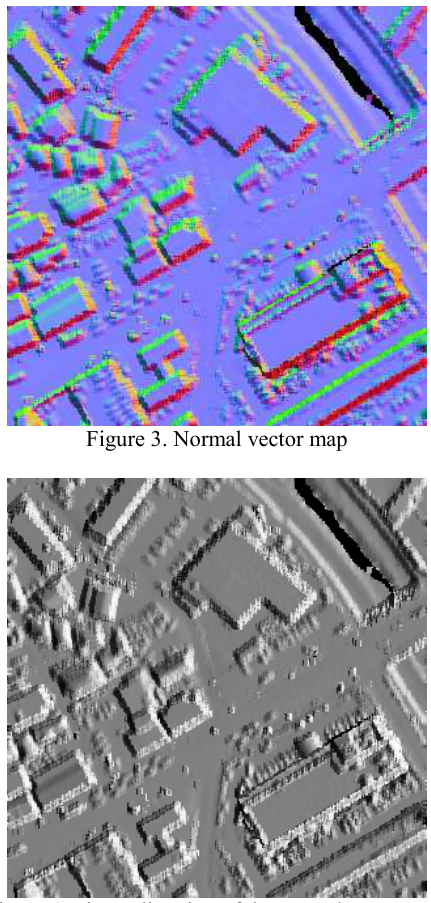
Figure 4. The X direction of the normal vector map